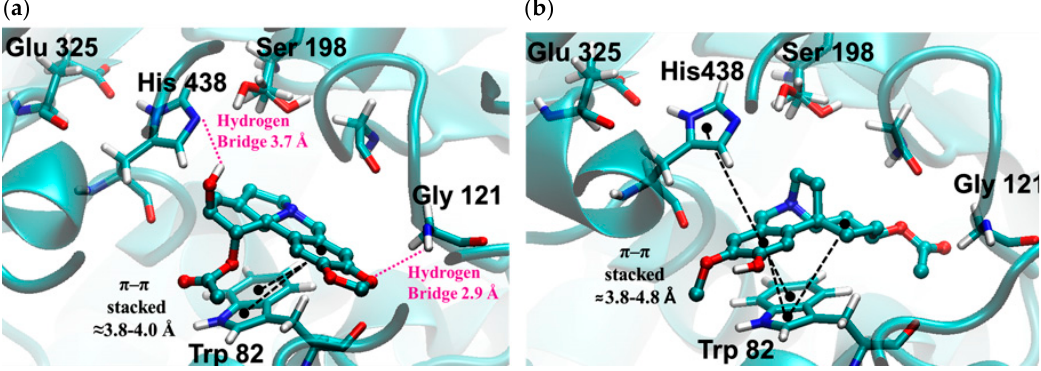
Figure 6. Graphical representations of the binding of ( a ) 1- O -acetyllycorine ( 5 ) and ( b ) cantabricine ( 11 ) in the gorge of the active site of hBuChE.